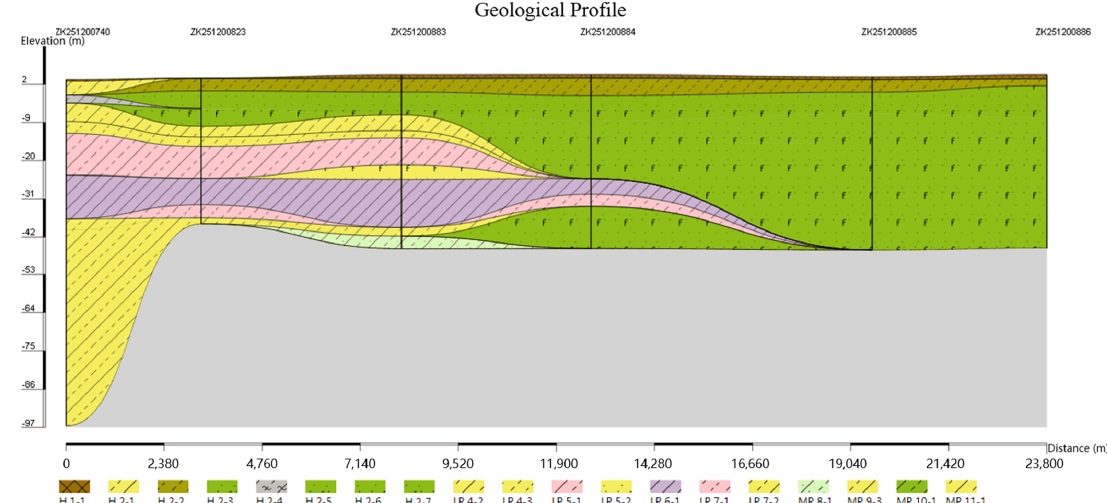
Figure 16. Geological profile IX corresponding to drilling line IX in Figure 12 by unique path method. A typical profile map of the Lixiahe Plain–Yangtze River Delta floodplain is selected for observation. Figure 17 also presents a north-south geological profile. From left to right, corresponding to the map from north to south, the lithological units gradually taper out, whereas the silt unit is greatly expanding.